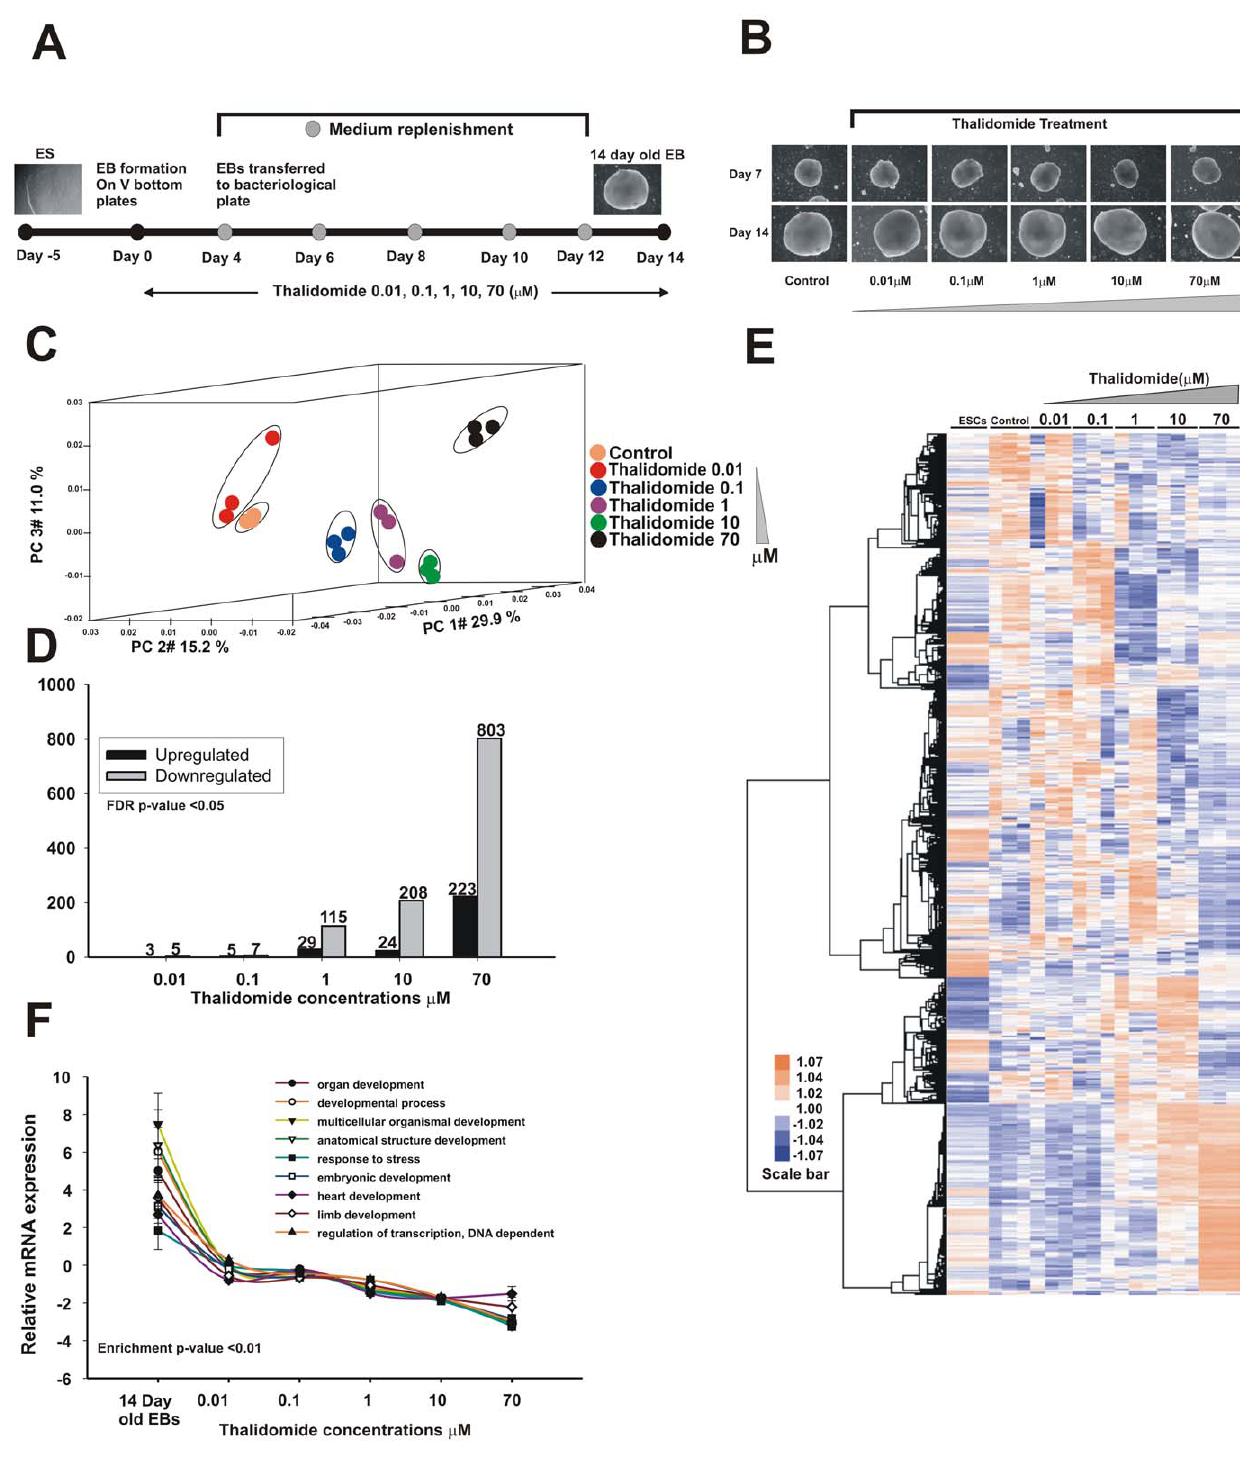
Figure 3. Dose-dependent gene expression response of thalidomide in hESC differentiation. A , The experimental approach of hESC differentiation and thalidomide treatment. B , Selected thalidomide concentrations do not induce any cytotoxicity in hESC differentiation. The scale bar represents 250 m m. C , 3D PCA showed that thalidomide treatment induces the changes in the gene expression pattern with increasing concentration. The 3 biological replicates for each sample group are showed in single colour. D , The number of DEG progressively increased with thalidomide concentration. Black shows up-regulated and grey shows down-regulated transcripts. Fold change $ 2 or #2 2, (p # 0.05). E , An unsupervised hierarchical clustering of DEG demonstrated a dose-dependent repression. The highly expressed genes in untreated control were repressed for thalidomide in a concentration dependent manner. Data represents from 3 biological replicates. F , To quantify the BP the average relative fold change values were calculated manually (for all transcripts present in each GO) and represented for 14 day old EBs and thalidomide treatment. The error bar represents SEM from fold change values for transcripts belong to each GO.